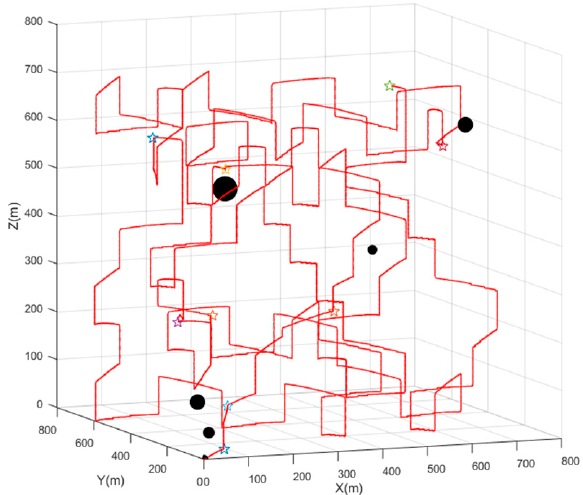
Figure 17. The target search trajectory of no attraction source.